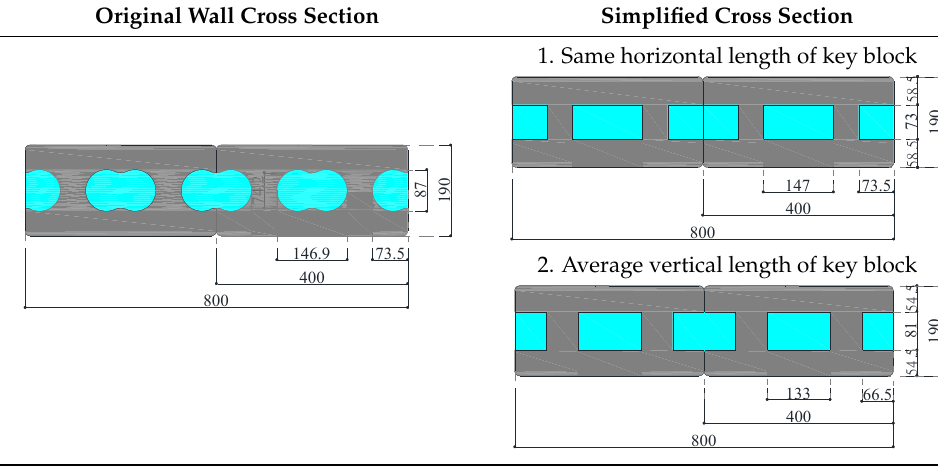
Table 7. Maximum load and tensile stress.